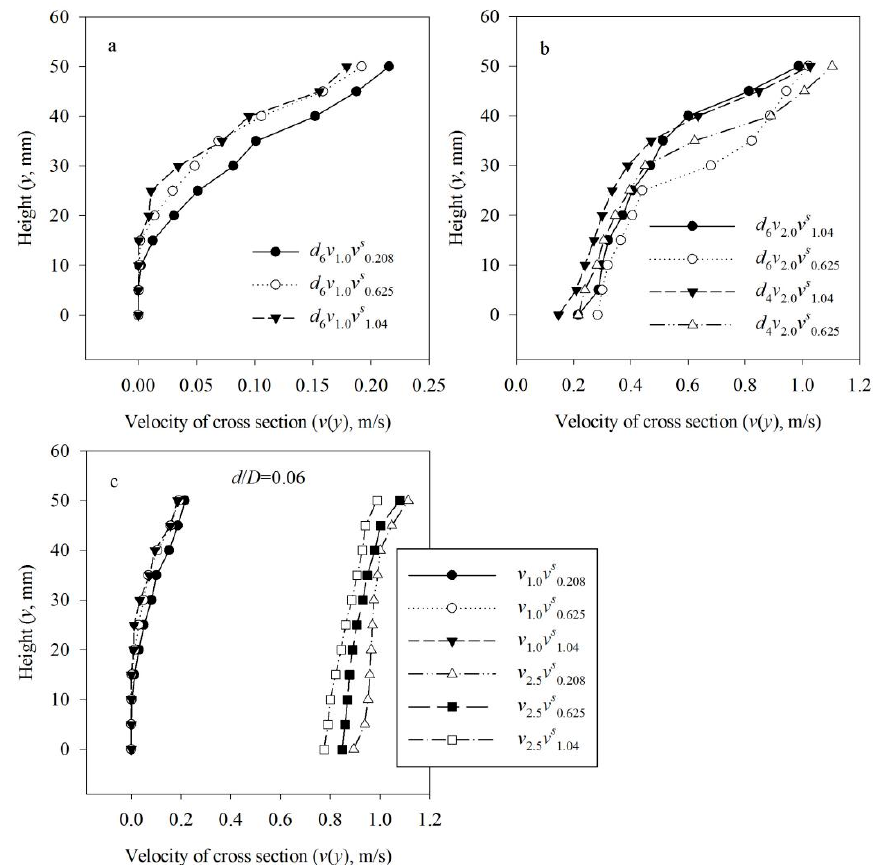
Figure 11. Relationship between particle vertical velocity distribution and sediment transport rate. ( a ), aggregate transportation; ( b ), saltation transportation; ( c ), suspension transportation.